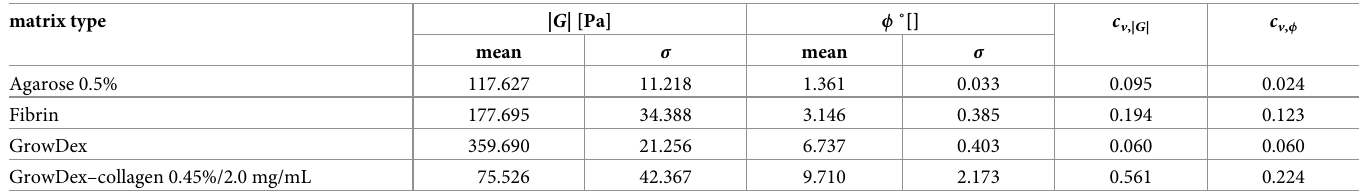
1.35% agarose matrices, the analysis pipeline underperformed due a low displacement signal- to-noise ratio. The measurements determined the upper bound of stiffness for the used analy- sis pipeline and the microrheometer. Further, the phase-angle values of the agarose matrices with the varying concentration are shown in Fig 6B and Table 2. Parallel-plate rheometry is Table 3. Parallel-plate rheometry for comparing sample-to-sample variation. Sample-to-sample variation is quantified based on coefficient of variation that is the ratio between standard deviation ( σ ) and mean. The coefficients of variation for shear modulus ( c v ,| G | ) and for phase angle ( c v , ϕ ) are shown. matrix